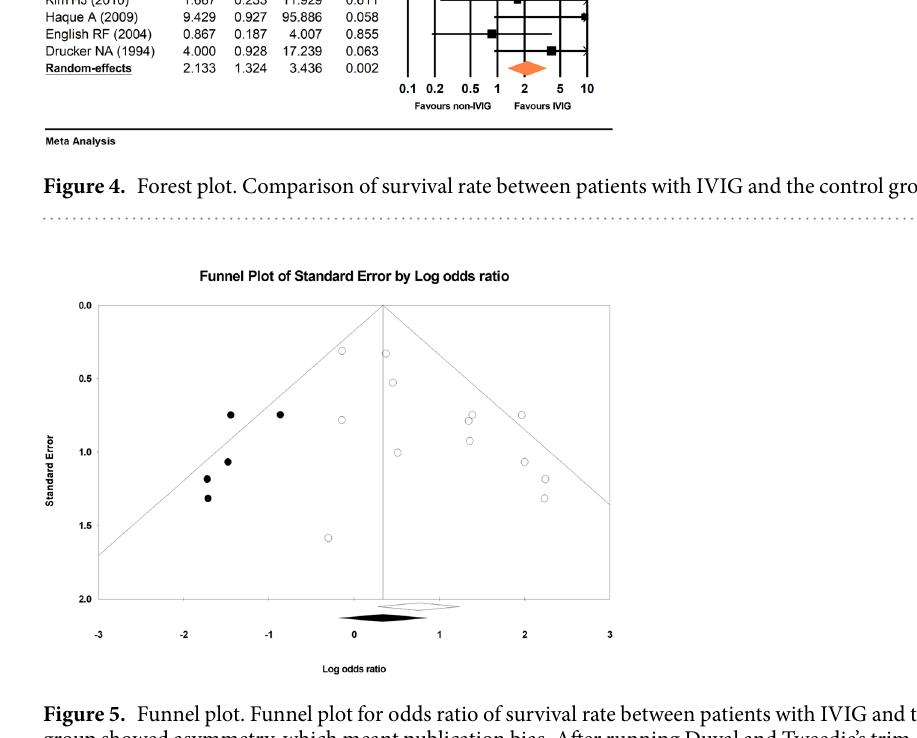
Figure 5. Funnel plot. Funnel plot for odds ratio of survival rate between patients with IVIG and the control group showed asymmetry, which meant publication bias. After running Duval and Tweedie’s trim-and-fill method by Comprehensive Meta-Analysis software, five missing studies were